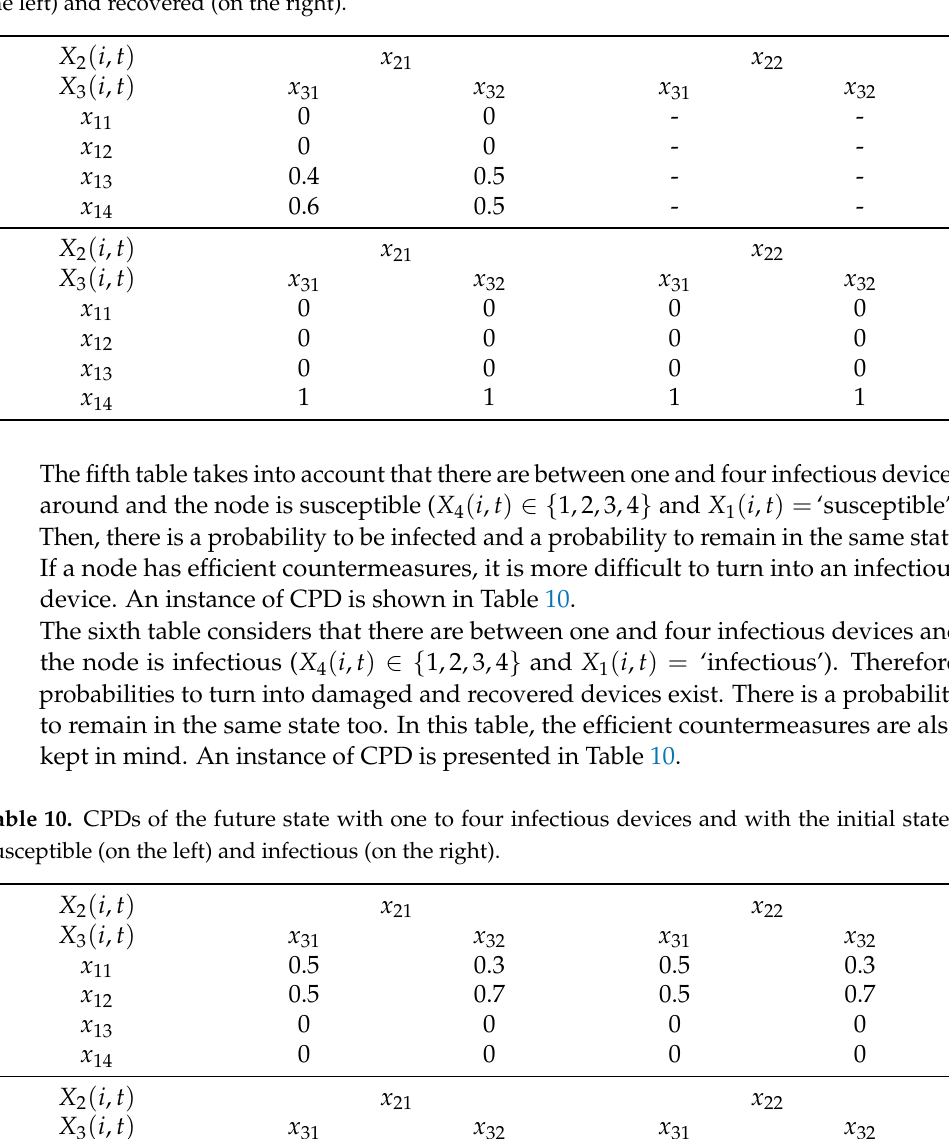
Table 9. CPDs of the future state without infectious devices and with the initial states: damaged (on the left) and recovered (on the right).